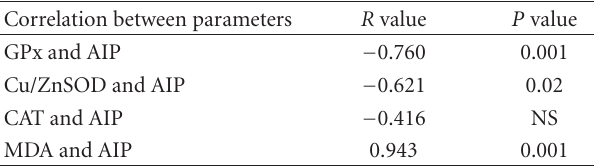
Table 3: Correlation between antioxidant enzymes and atherogenic index of plasma in SCD with chronic kidney